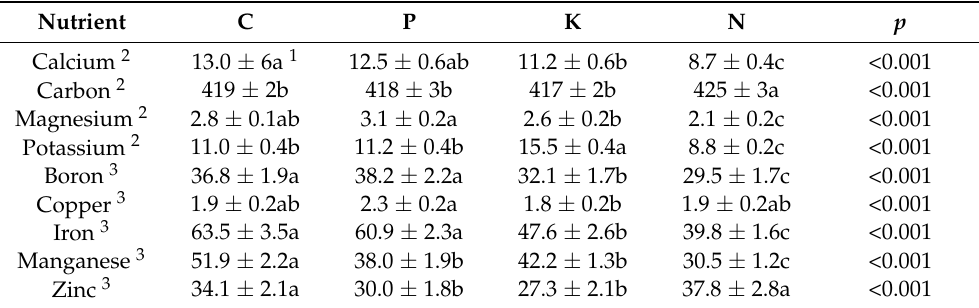
Table 4. The influence of N, P, or K fertilization on nutrient concentrations of Serianthes leaves. Mean of Serianthes grandiflora and Serianthes nelsonii . C = control; P = phosphorus fertilization; K = potassium fertilization; N = nitrogen fertilization. Mean ± SE, n = 12.